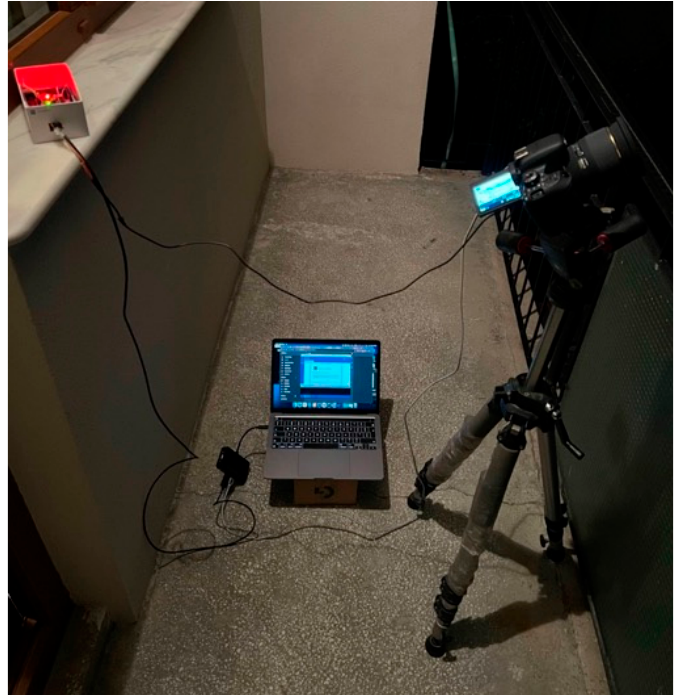
Figure 2. One assembled portable SST system.